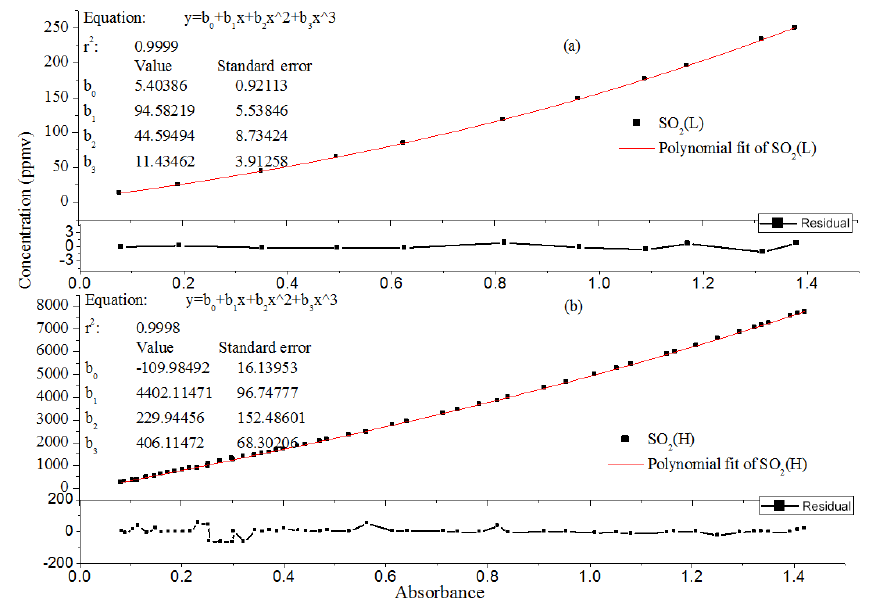
Figure 5. Calibration curves for the SO 2 (L) (a) and SO 2 (H) (b) as a result of least squares fitting using a third-order polynomial